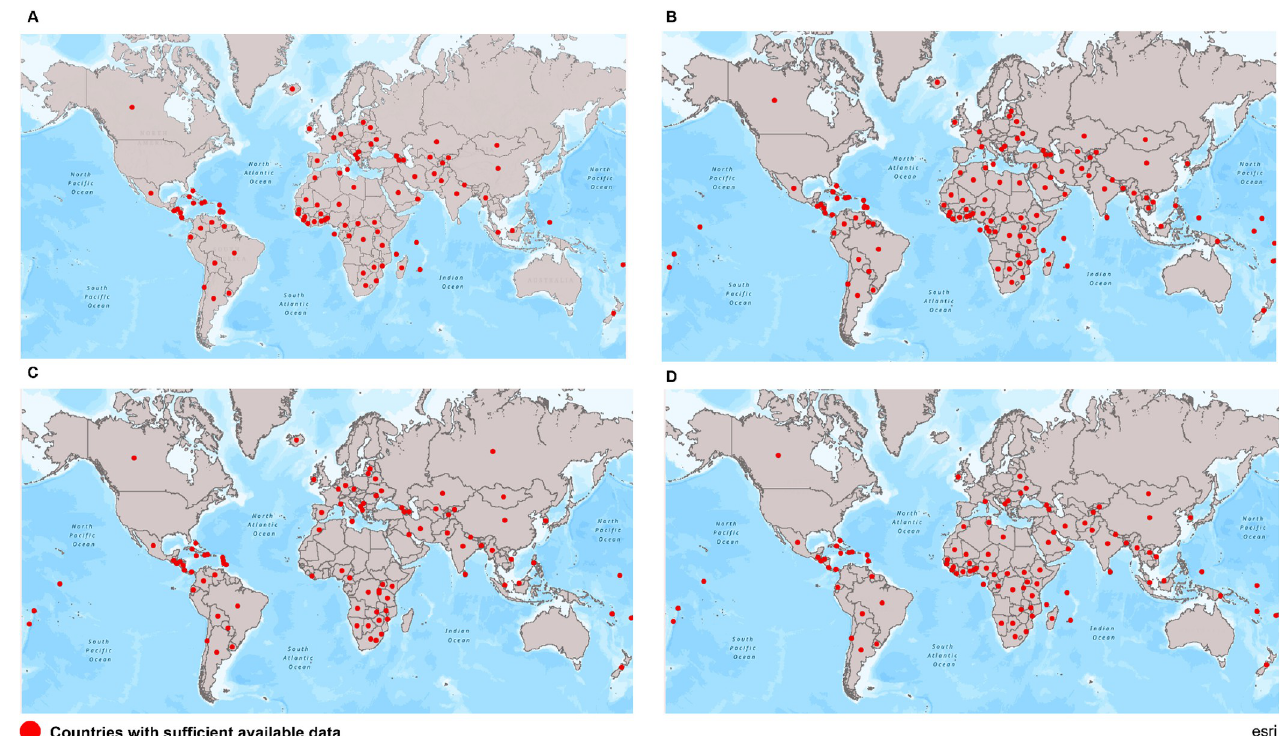
Fig 3. Countries with sufficient available data for key population stigma indicators. (A) Sexual behavior/orientation stigma related to men who have sex with men. (B) Sex work stigma. (C) Gender identity stigma related to transgender persons. (D) Drug use stigma. � Data were available for more than 40% of indicators. Base layers of the maps used are from ArcGIS, ESRI: Fig 3A: https://arcg.is/bu8Cu0. Fig 3B: https://arcg.is/Pbzn00. Fig 3C: https://arcg.is/0G0PDG. Fig 3D: https://arcg.is/1HS1zT.